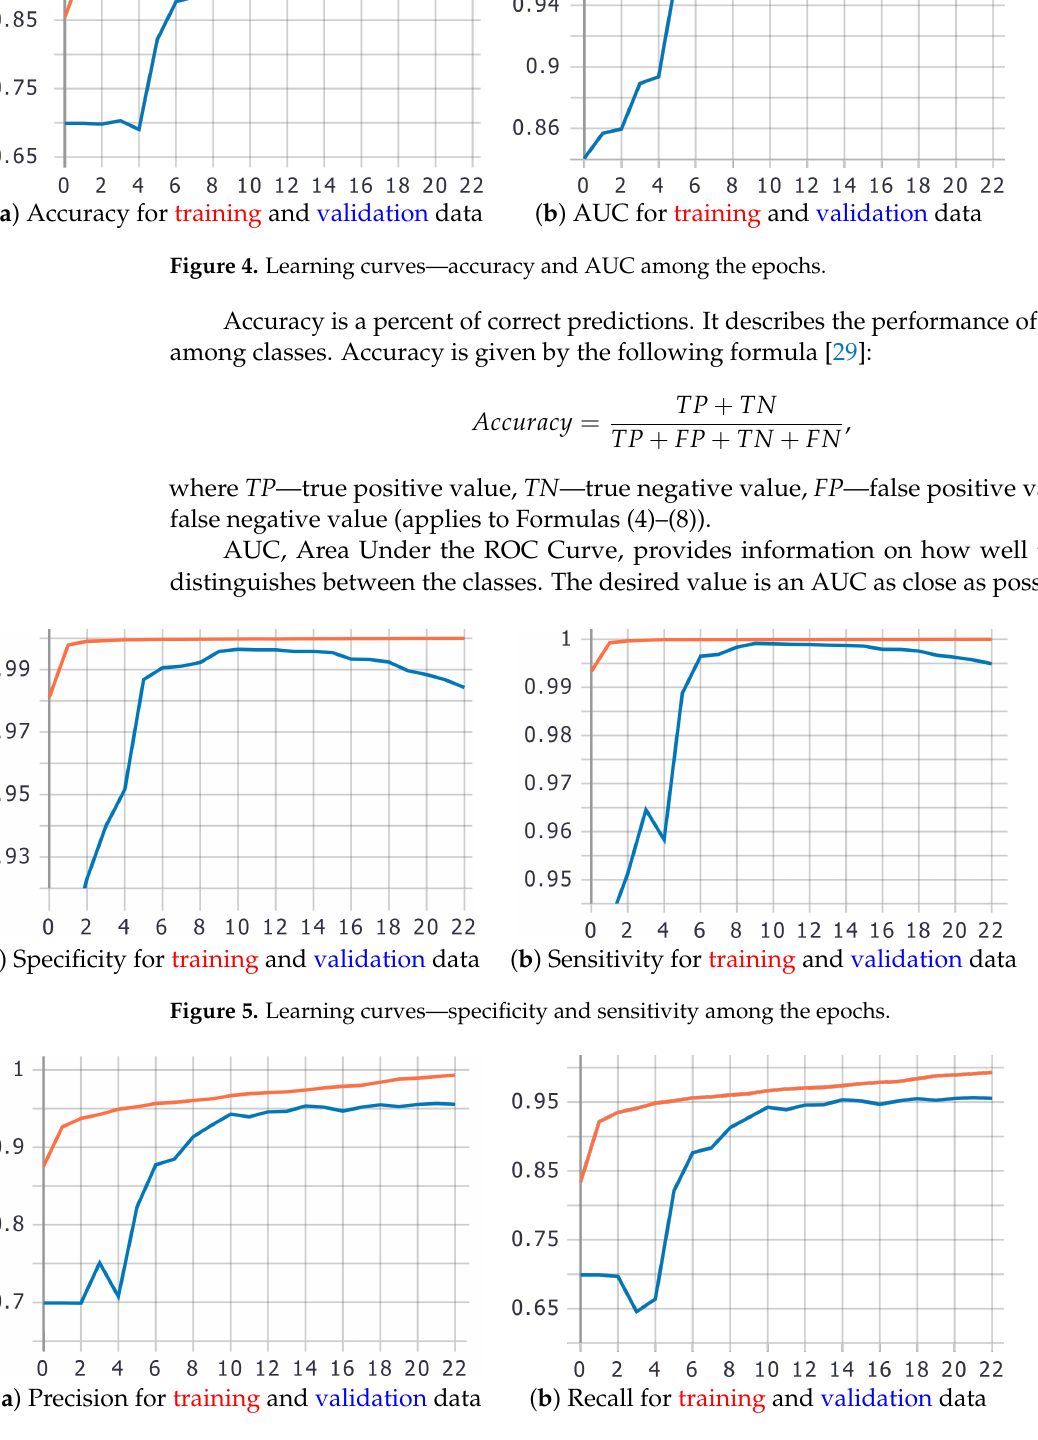
Figure 6. Learning curves—precision and recall among the